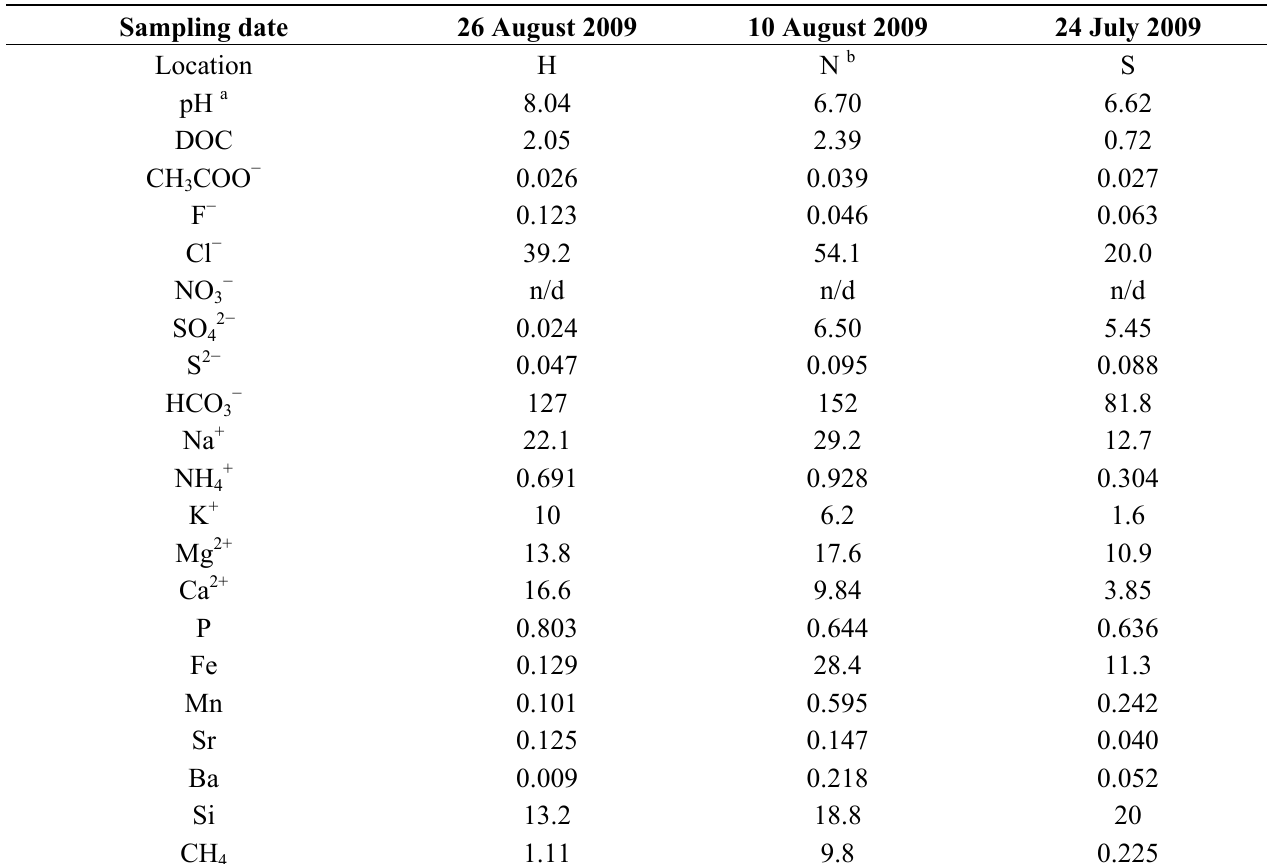
Table 3. Chemical composition of groundwater samples from